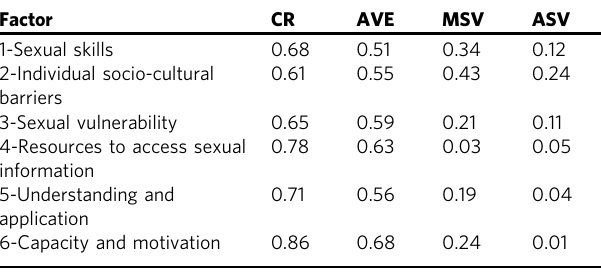
Table 3 The convergent validity and discriminant validity for the SHLS-106 CFA model.